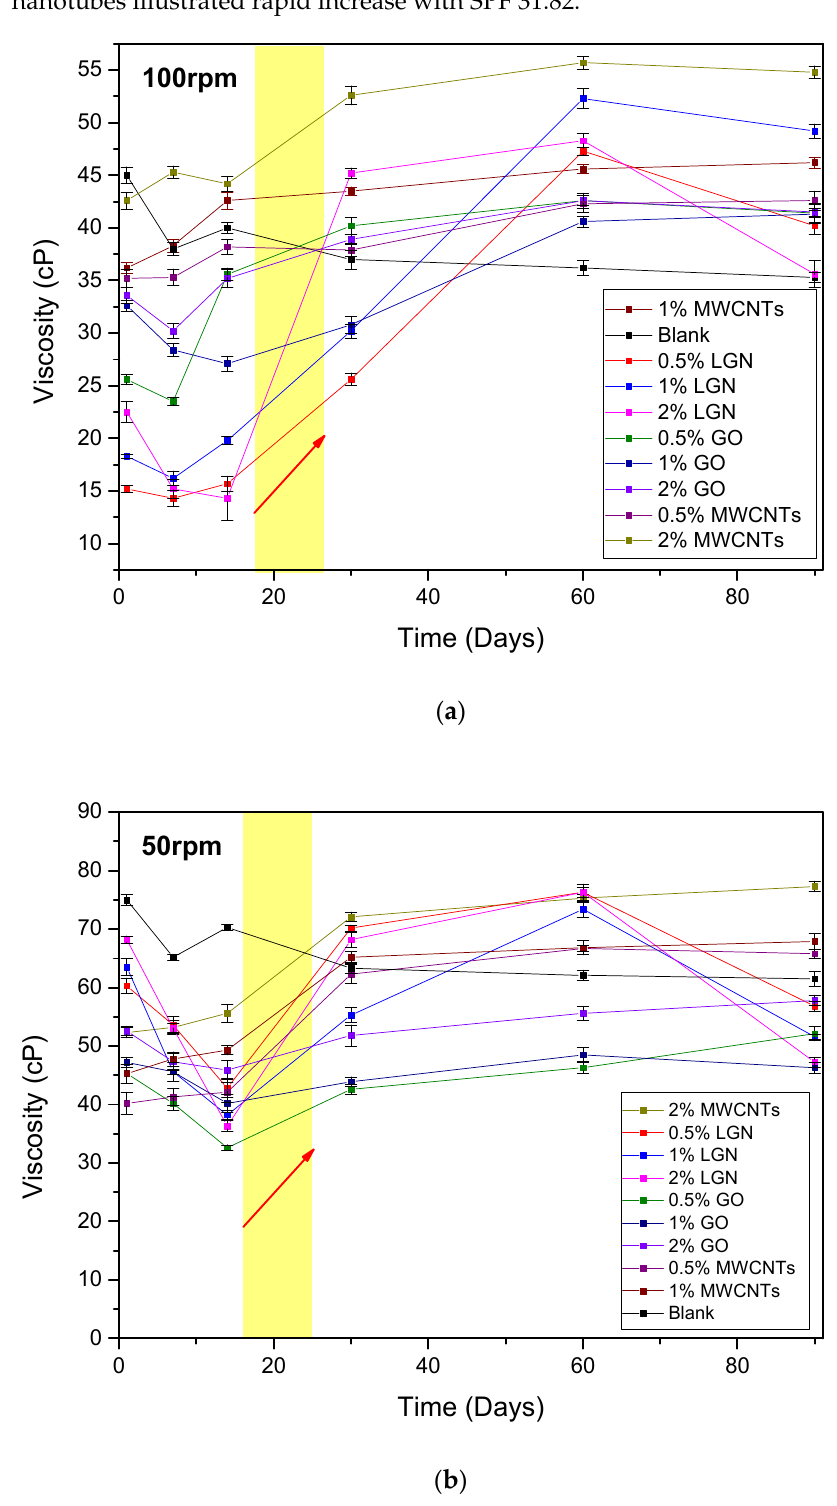
Figure 4. ( a ) Viscosity values at 100 RPM of the prepared emulsions during 90 days of storage. ( b ) Viscosity values at 50 RPM of the prepared emulsions during 90 days of storage.